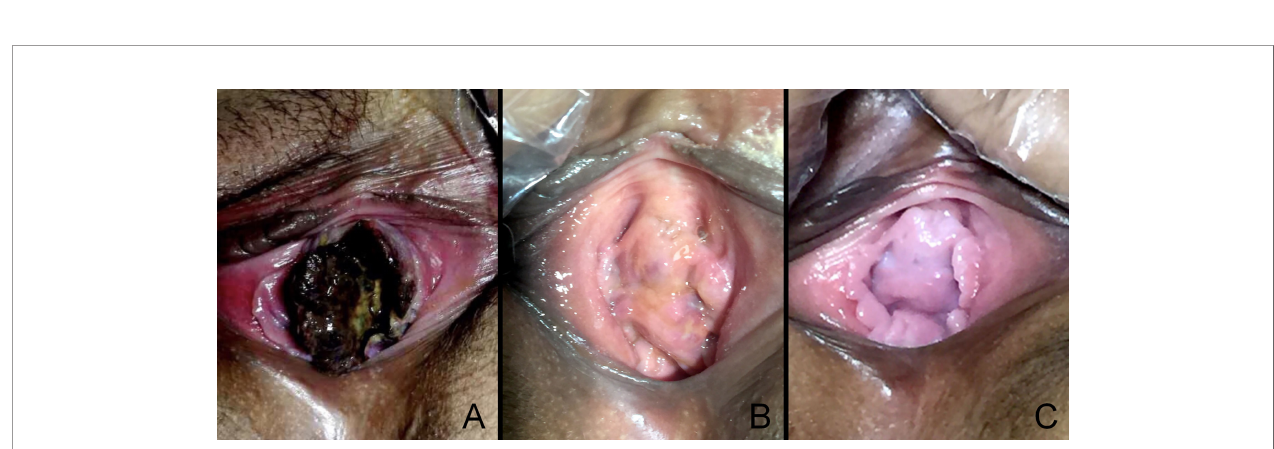
FIGURE 4 | The vaginal metastasis choriocarcinoma, which contained blood clots and necrotic tissue before chemotherapy (A) , at 30 days postdelivery (B) , at 90 days postdelivery when fi nished with EMA/CO chemotherapy (C)